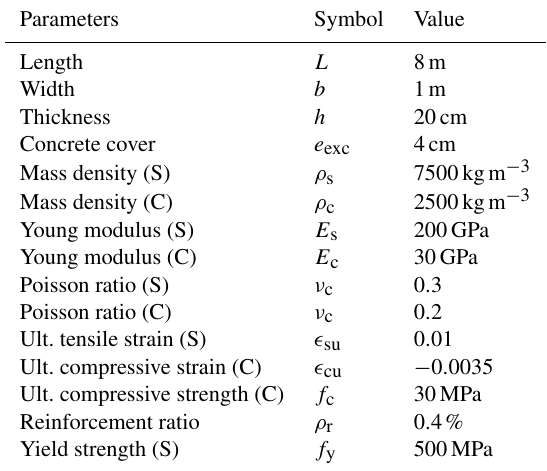
Table 1. Parameter values for models comparison. The following notations are adopted: Ult. is an abbreviation of ultimate, S signifies steel, and C signifies